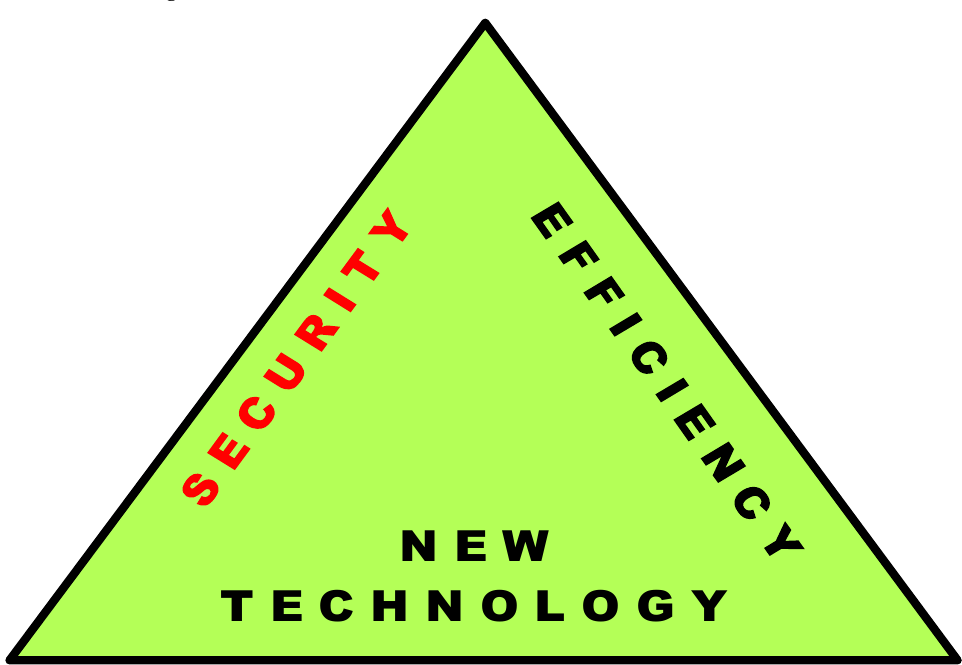
Figure 1. Features of standard for carrying out mining production process. Source: own study based on [21]. on